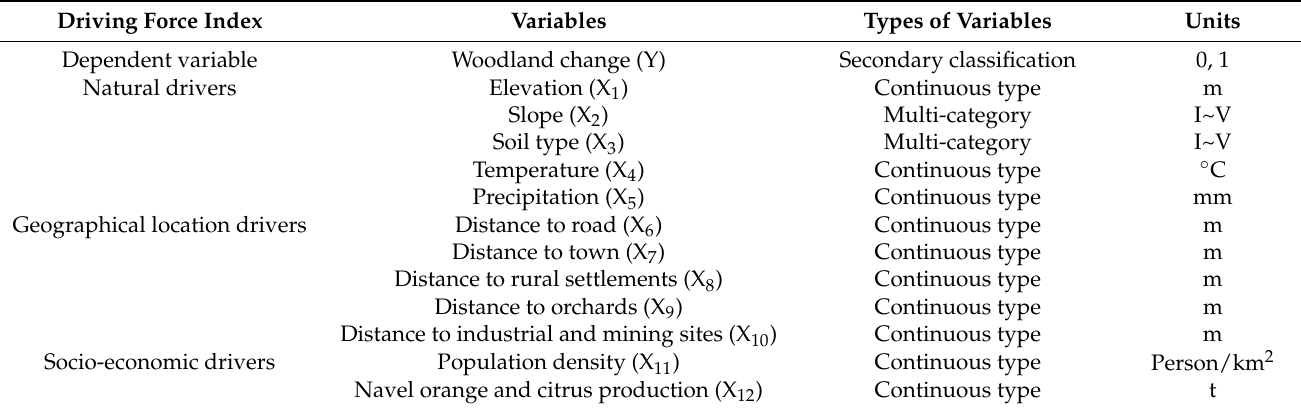
Table 4. Driving indicators of forest land change in Anyuan County,